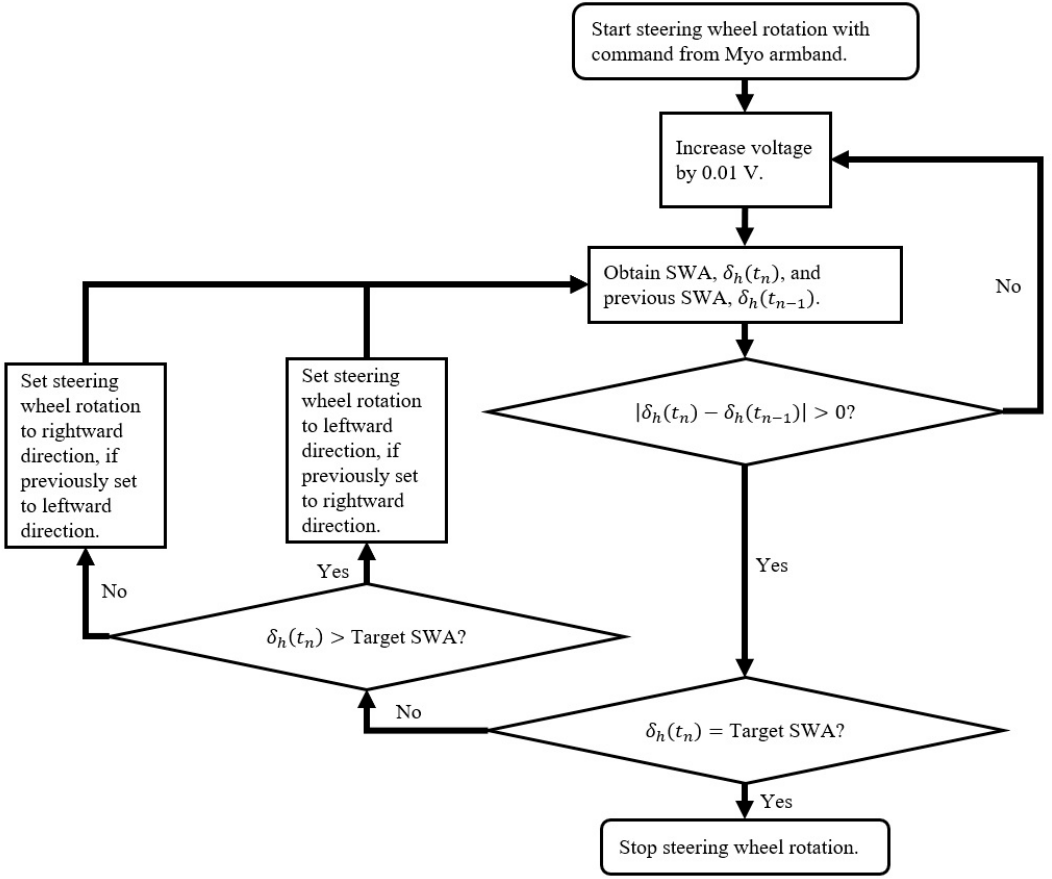
Figure 4. Steering wheel angle control algorithm for rightward steering wheel rotation.